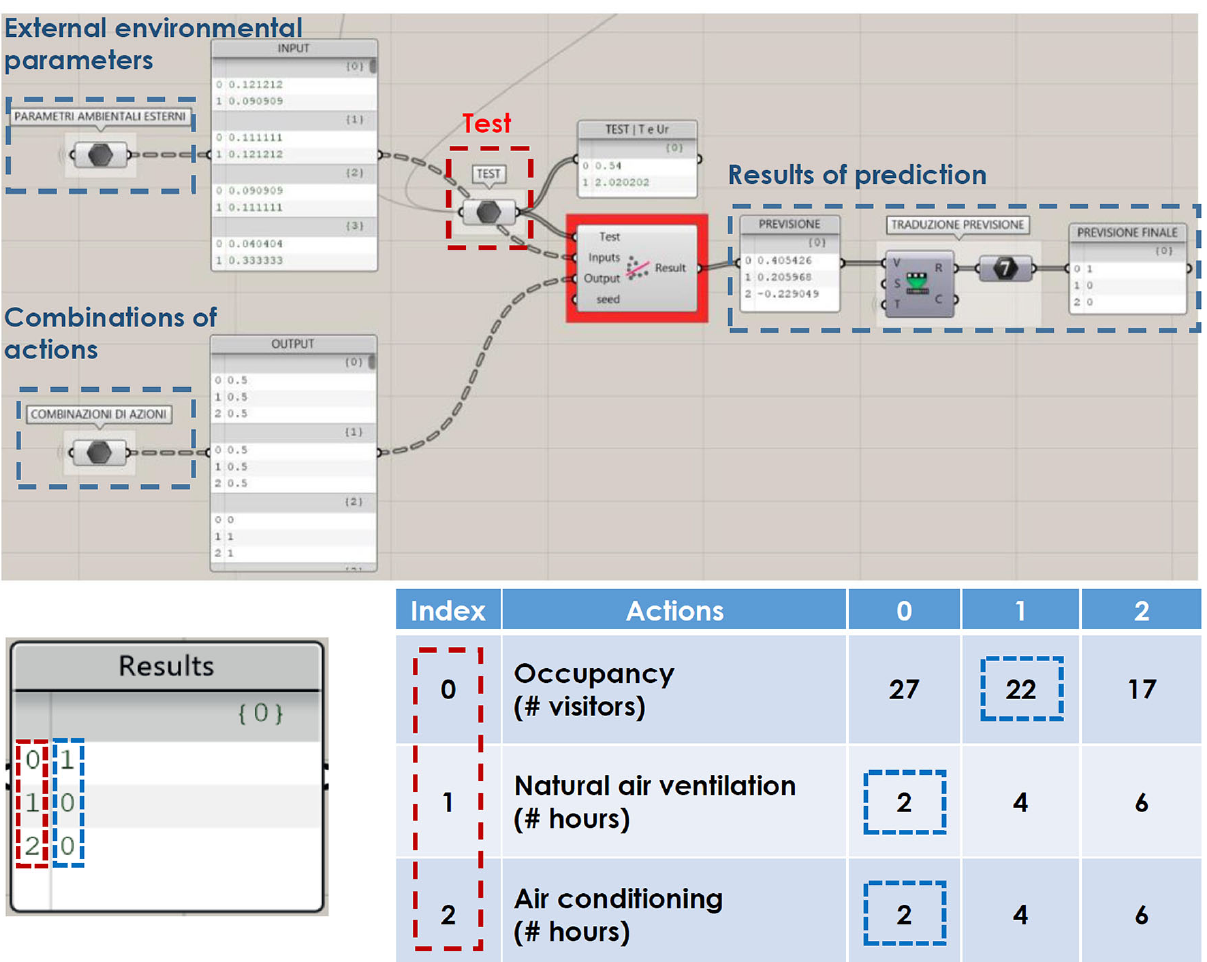
Figure 9. DSS code in Grasshopper and results of the simulation. In this example, with an outdoor temperature of 40 °C and with a relative humidity of 0.54, the DSS suggests the combination of actions { 1; 0; 0 } which (translated) means to allow access to only 22 users, to allow natural ventilation for 2 hours and 2 hours of predefined air conditioning